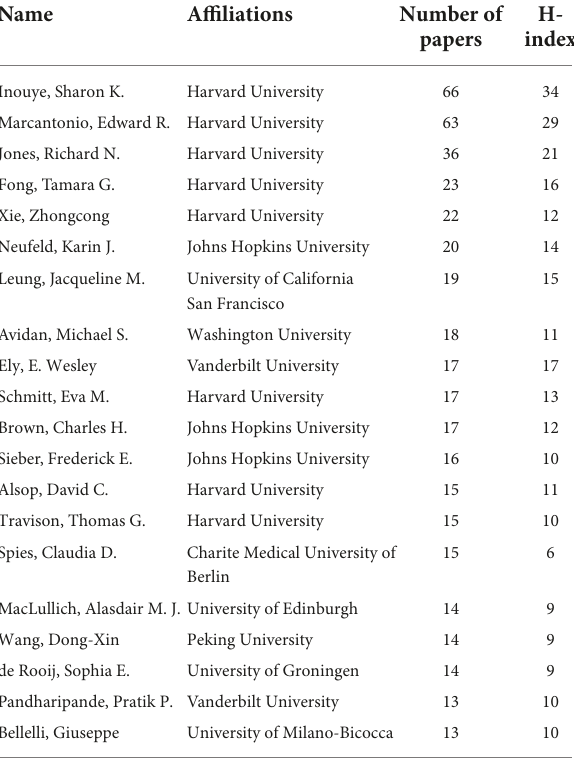
TABLE 2 The top 20 authors with the highest number of publications on postoperative delirium